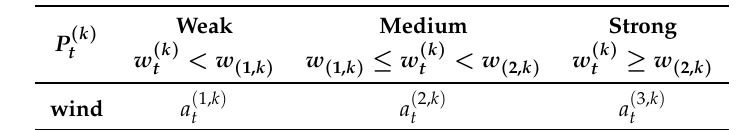
Figure 1. Flow scheme of the proposed DBN. Table 1. Probability of wind speed.